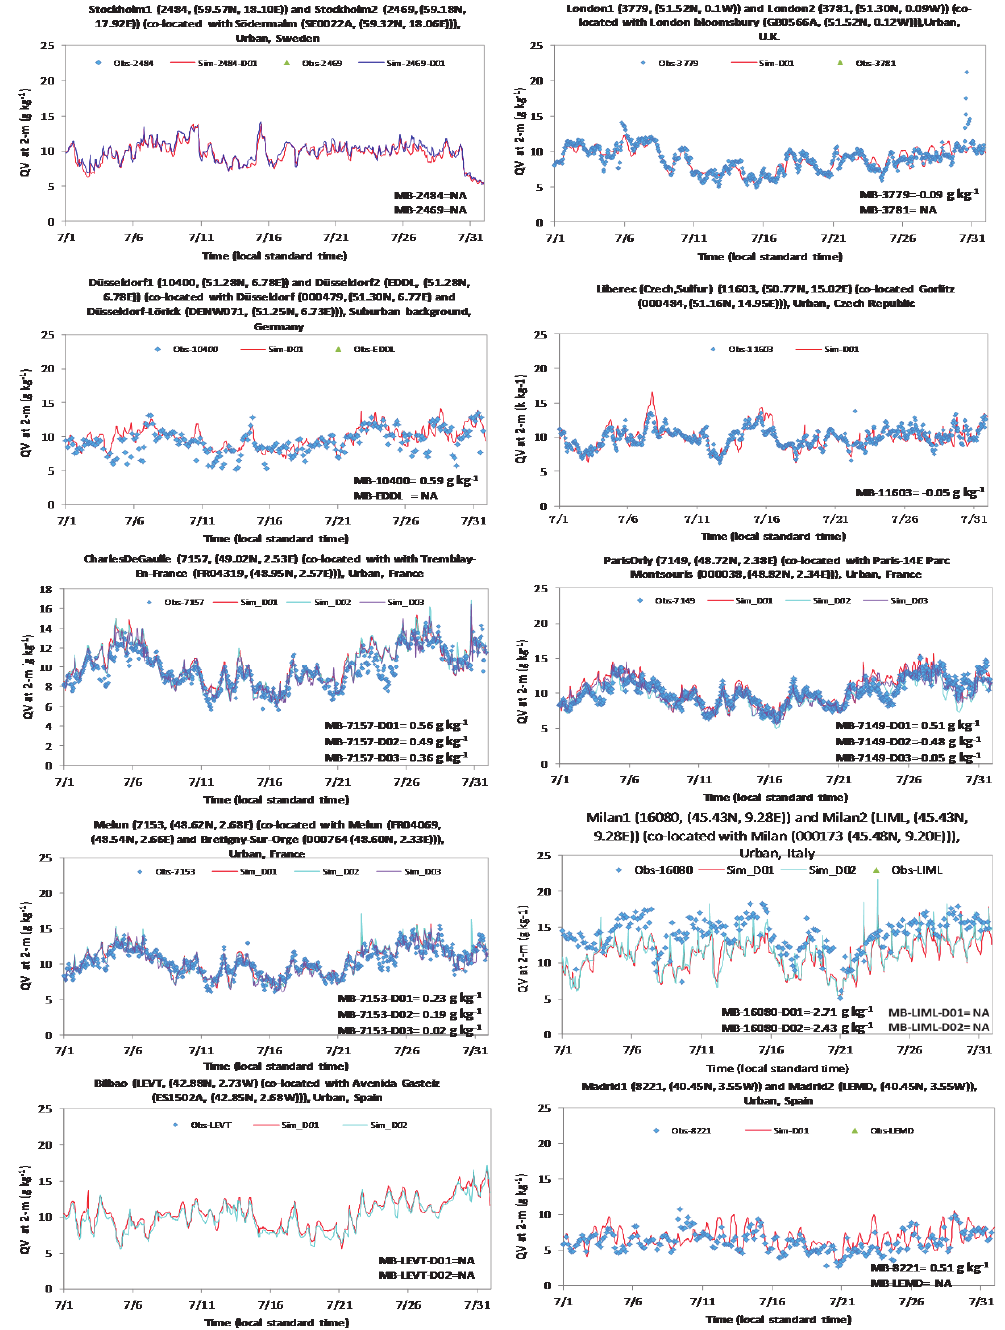
Figure 11. Simulated and observed 2-m specific humidity in July 2001 at selected sites. Statistics are not available (NA) at a few sites where observations were not available. Fig. 11. Simulated and observed 2m specific humidity in July 2001 at selected sites. Statistics is not available (NA) at a few sites where observations were not